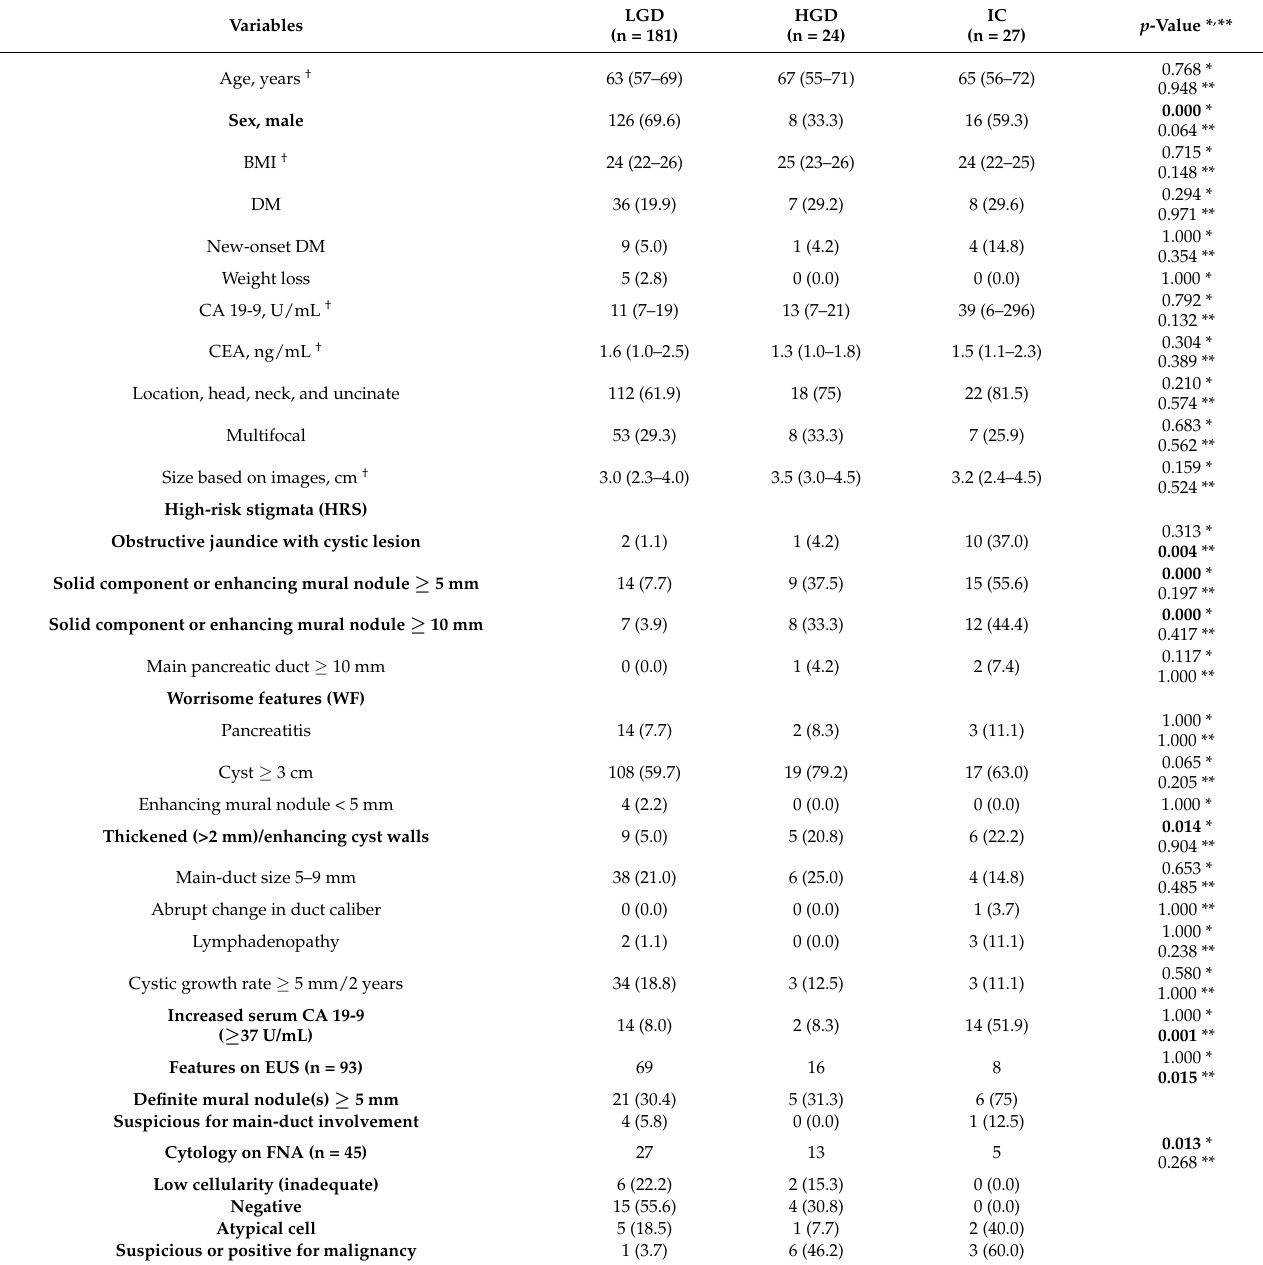
Table 1. Baseline